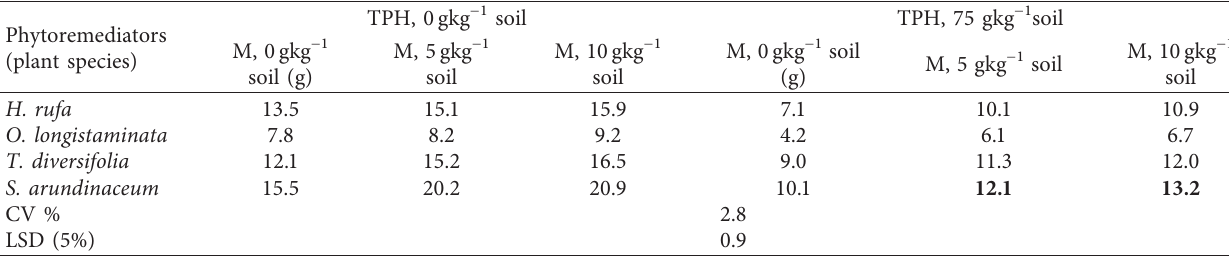
Table 4: Treatments effect on the total plant dry weight of four